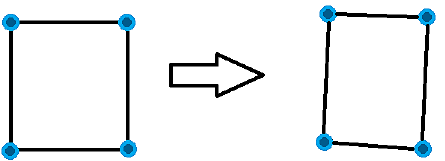
Figure 9. Transformation from world-corresponding points to sensor touch points in the image